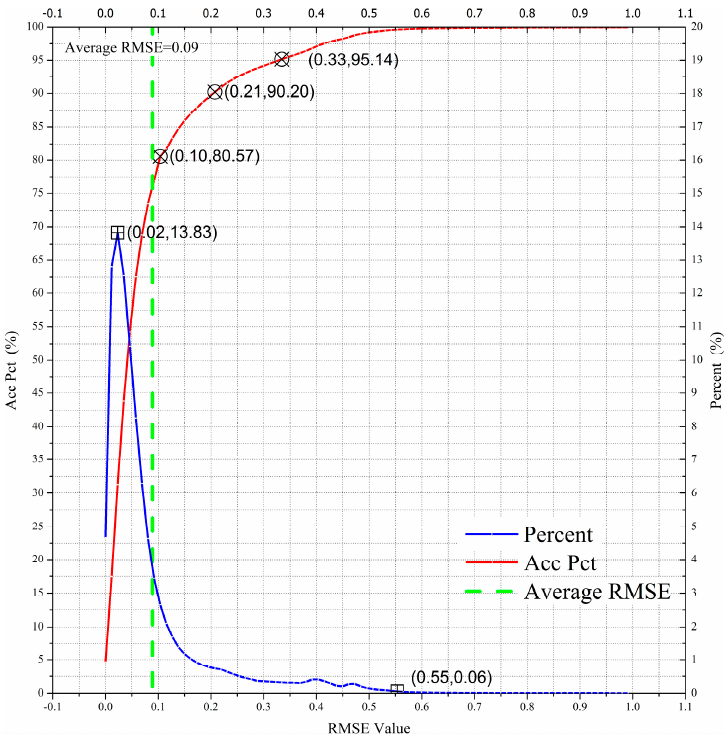
Figure 6. RMSE statistical result by pixels.